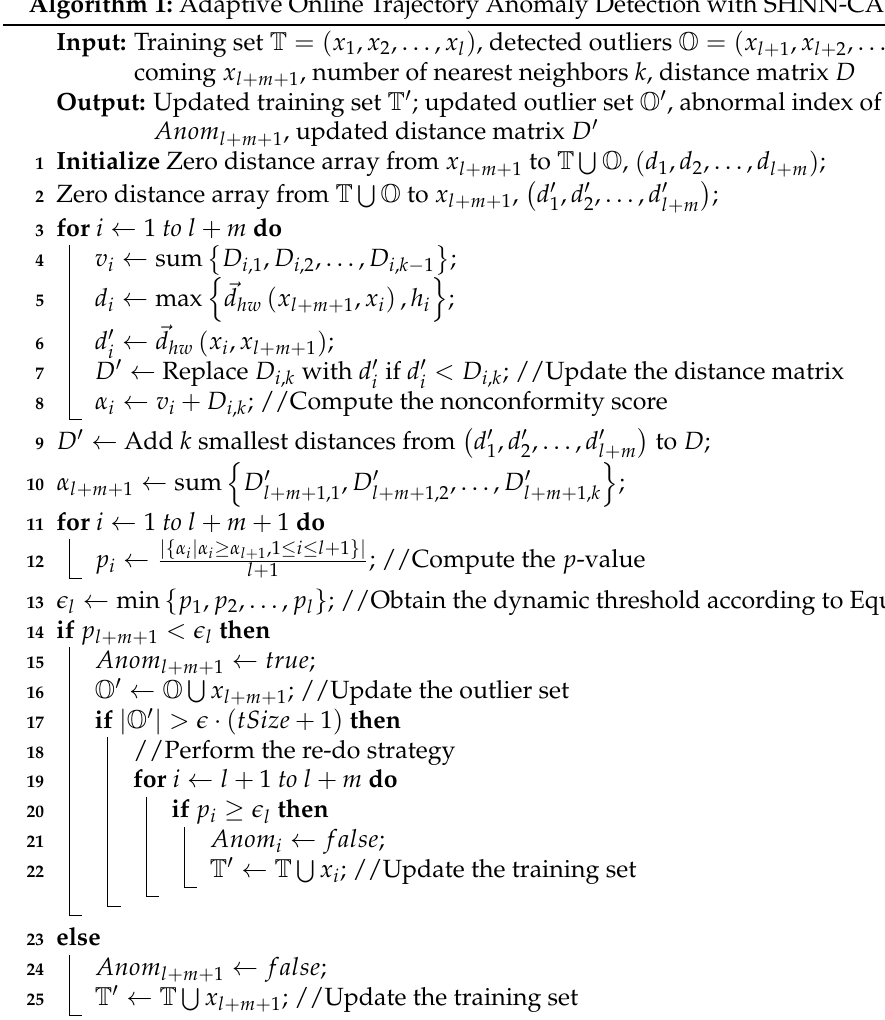
Algorithm 1: Adaptive Online Trajectory Anomaly Detection with SHNN-CAD